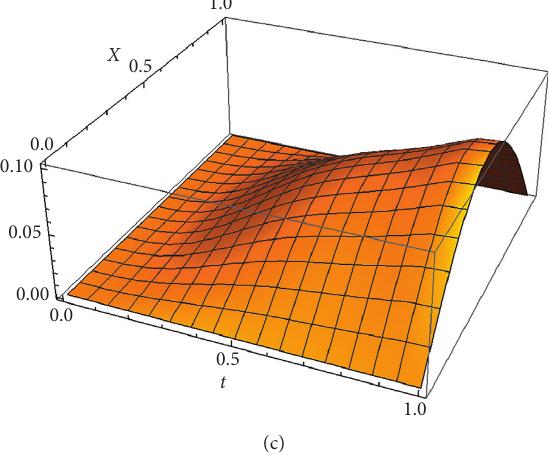
Figure 2: Displacements of a polybutadiene beam for P � 1 , 25 , 50.